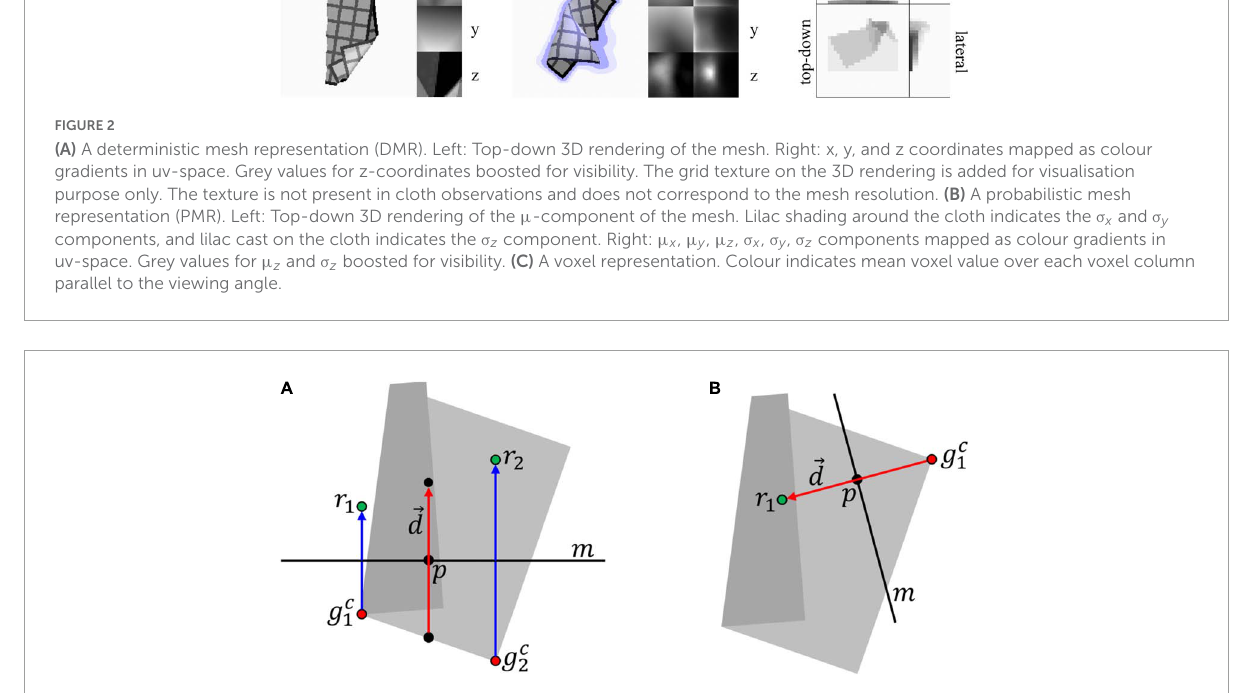
FIGURE3 Calculation of trajectories. (A) Dual-handed case. Trajectories (blue lines) and release points ( r 1 , r 2 ) are calculated from grasp points ( g C 1 , g C 2 ) and displacement vector → d . In this case, → d describes the displacement of the point in between the two grasp points. (B) Single-handed case. In this case, → d describes the displacement of the sole grasp point g C 1 , so release point r 1 is found by adding → d to g C 1 . The grey shape in the background is the 2D projection of the